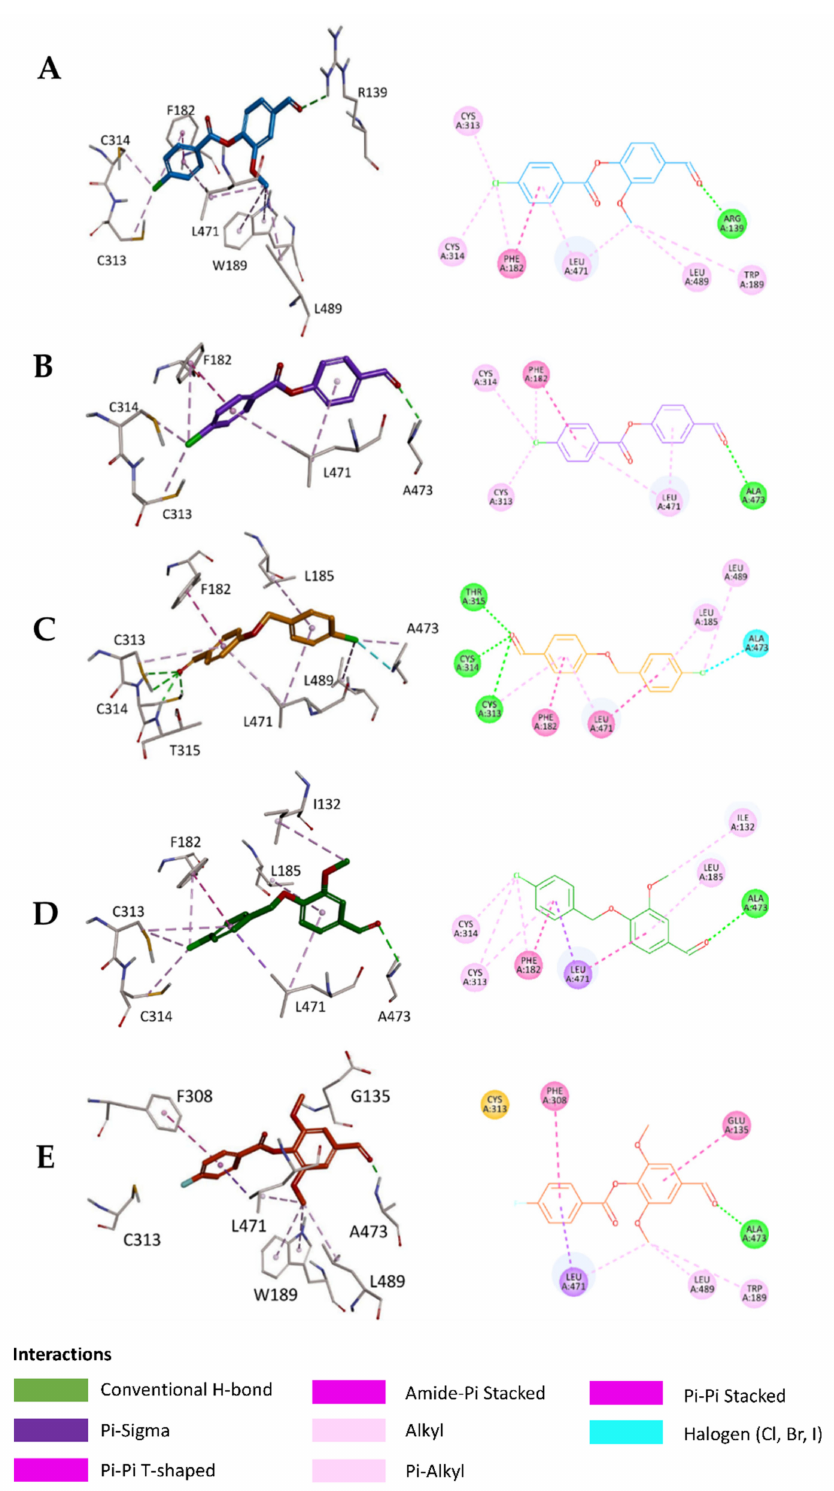
Figure 5. Molecular docking of: ( A ) ABMM-1 (cyan), ( B ) ABMM-2 (purple), ( C ) ABMM-15 (orange), ( D ) ABMM-16 (green) and ( E ) ABMM-18 (red) into the ALDH1A3 binding site (gray-colored